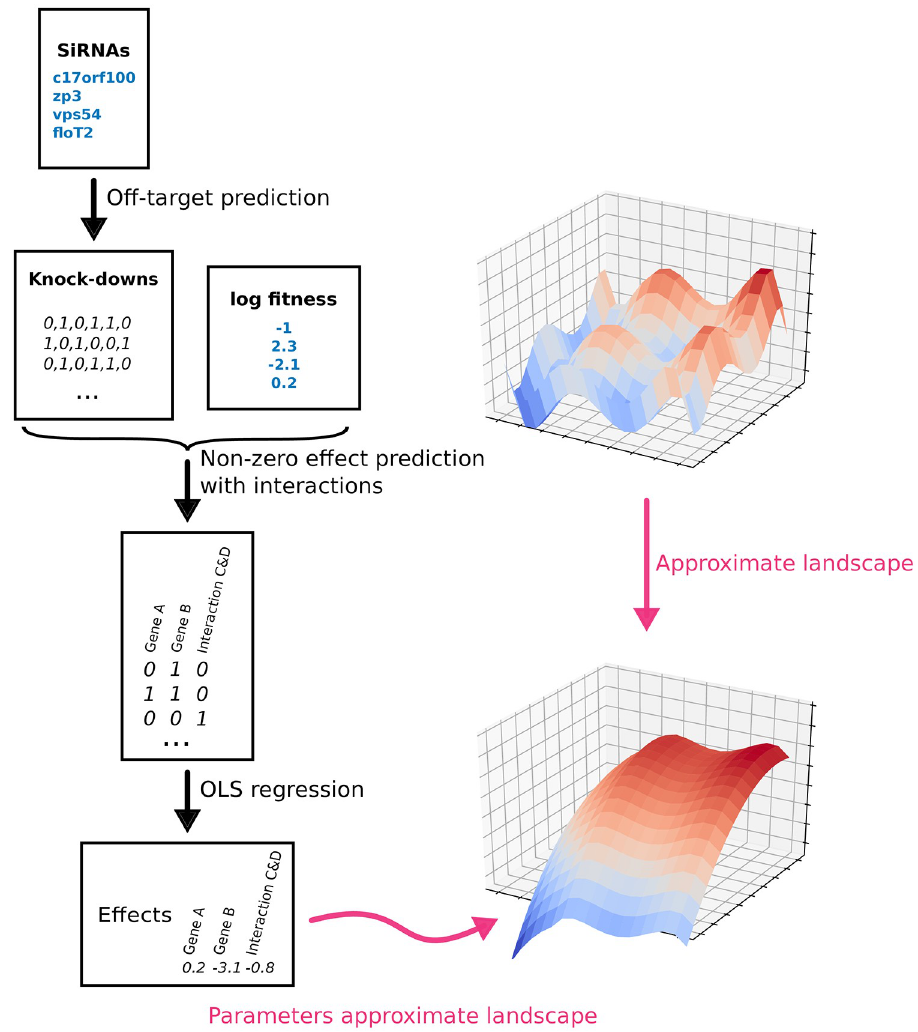
Fig 1. RNAi fitness landscape model. Black arrows indicate outputs that are actually produced. Red arrows indicate theoretical output.